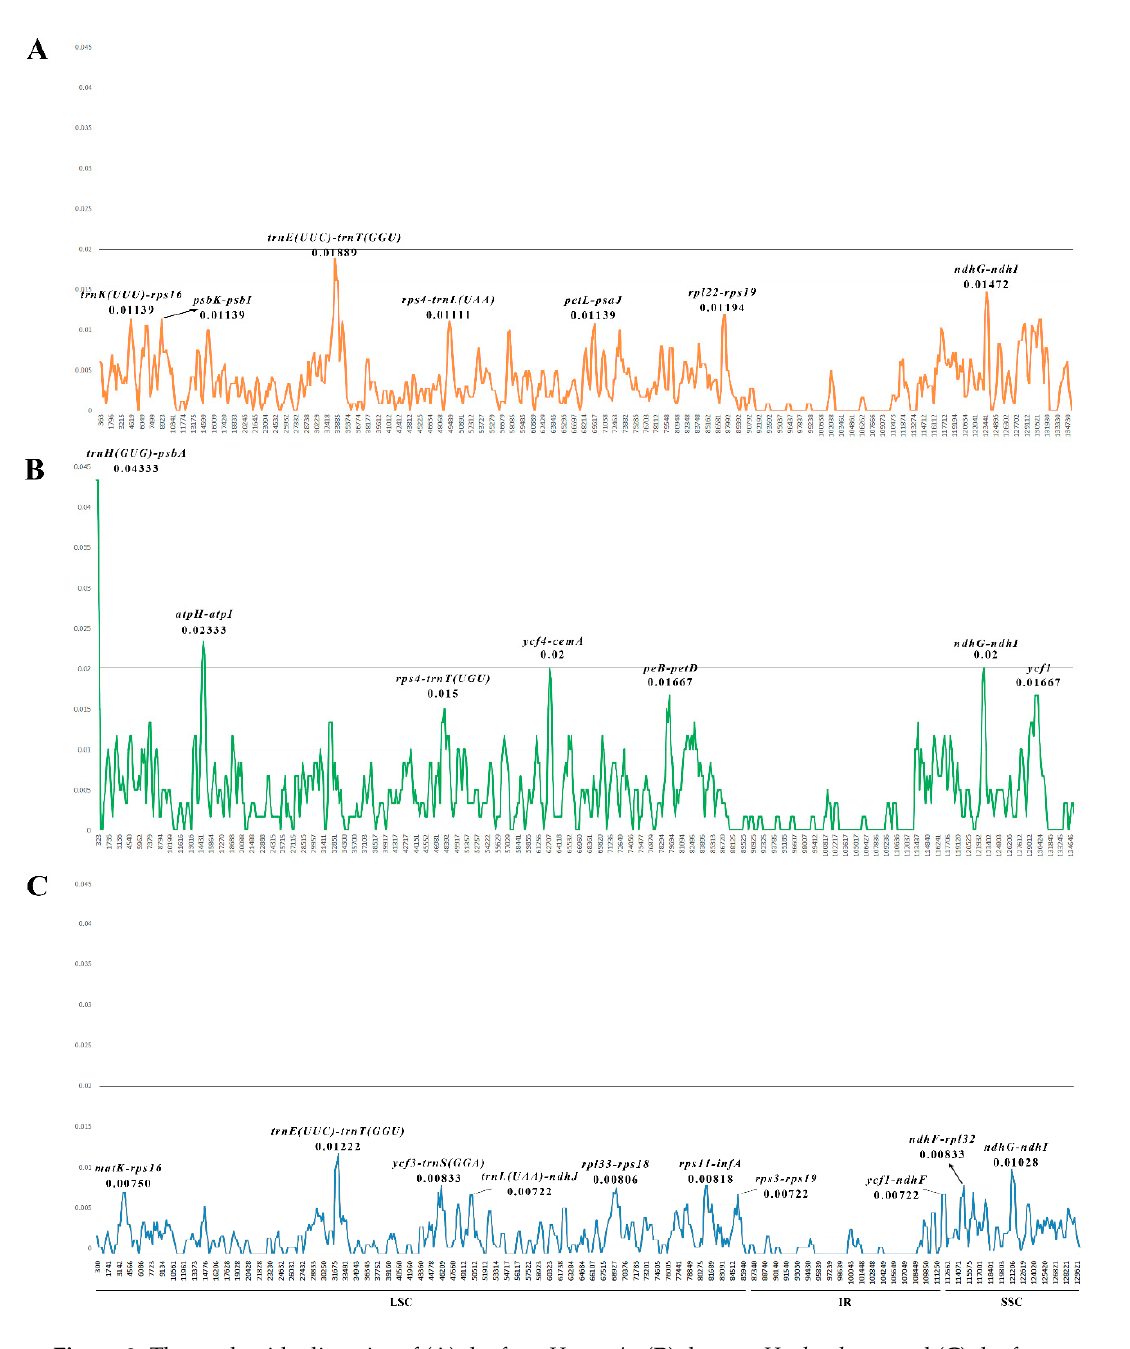
Figure 8. The nucleotide diversity of ( A ) the four Hansenia , ( B ) the two Haplosphaera and ( C ) the four Sinodielsia plastid genomes. The positions of 0.02 in all three graphs were marked by a line. Ten or seven regions with the highest Pi values were named out.